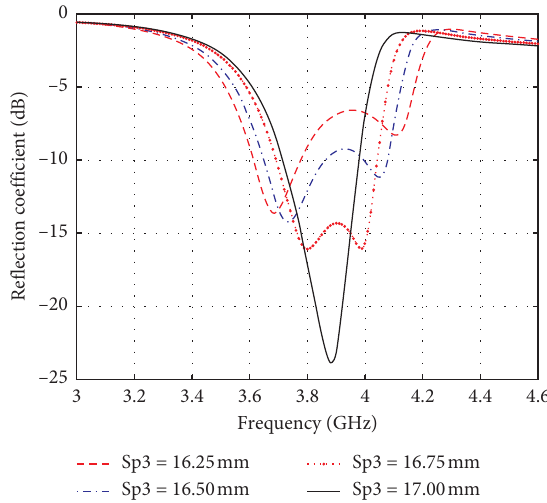
Figure 7: Variations in the reflection coefficient with changes in the slot position ( Sp ).